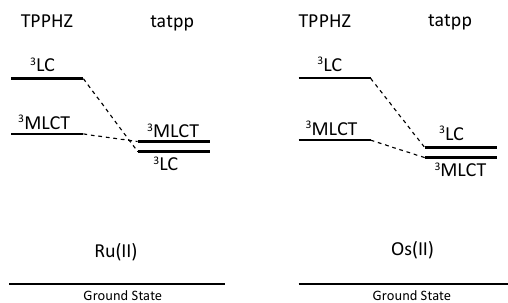
Figure 38. Relative energy of the 3 MLCT and 3 LC states of the Ru II and Os II complexes based on TPPHZ and tatpp [161].